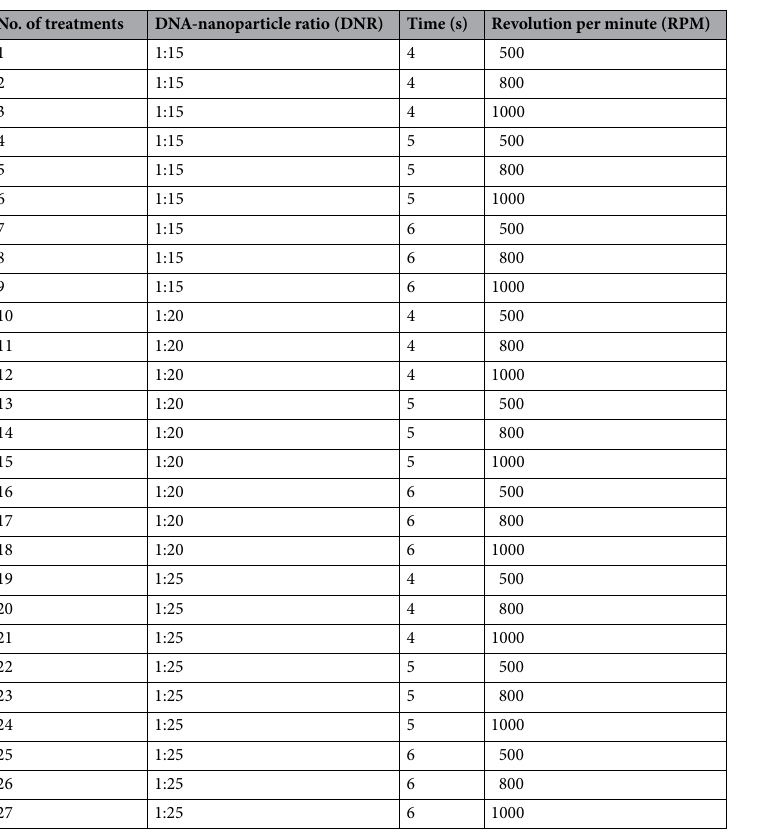
Table 1. Factors used for all 27 treatments.